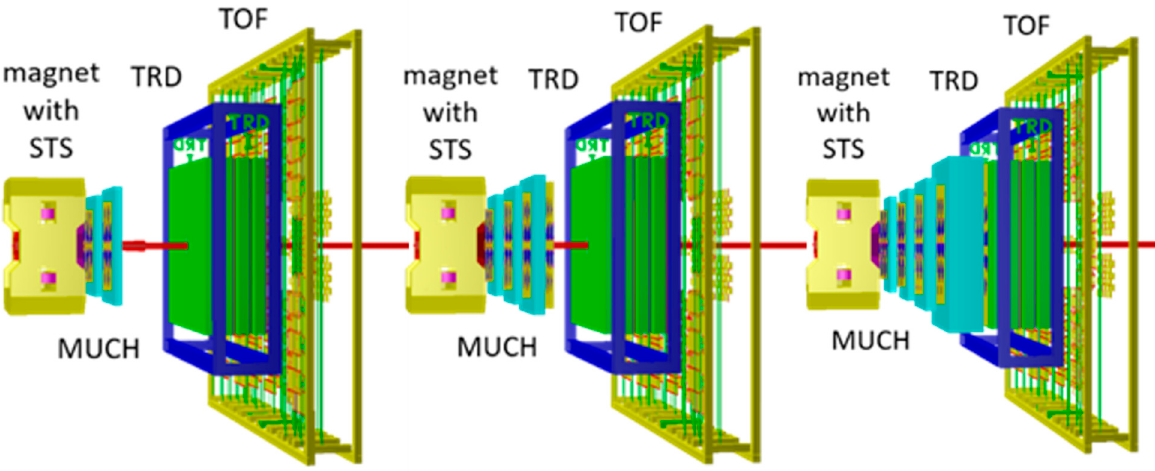
Figure 3. Three configurations of the CBM muon setup, which comprises the dipole magnet with the silicon tracking system inside, the muon chamber (MuCh) system, the transition radiation detector (TRD) as an additional tracking system, and the time-of-flight (TOF) detector. Left panel: MuCh with 3 absorber layers and 2 tracking stations. Center panel: 4 absorber layers and 4 tracking stations. Right panel: 5 absorber layers and 4 tracking stations (see text).